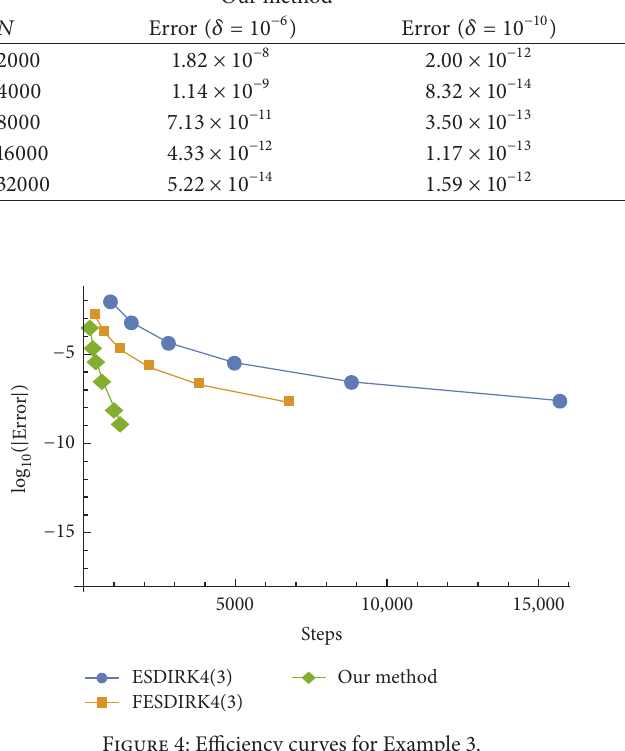
Figure 4: Efficiency curves for Example 3.